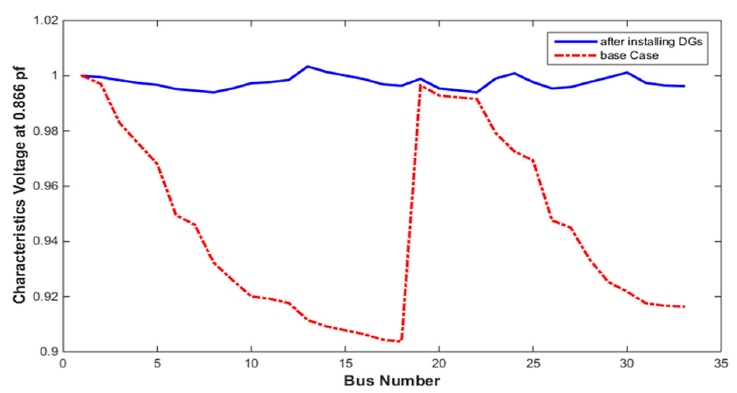
Figure 14. Characteristics of power loss, 33-bus system at 0.866 pf.